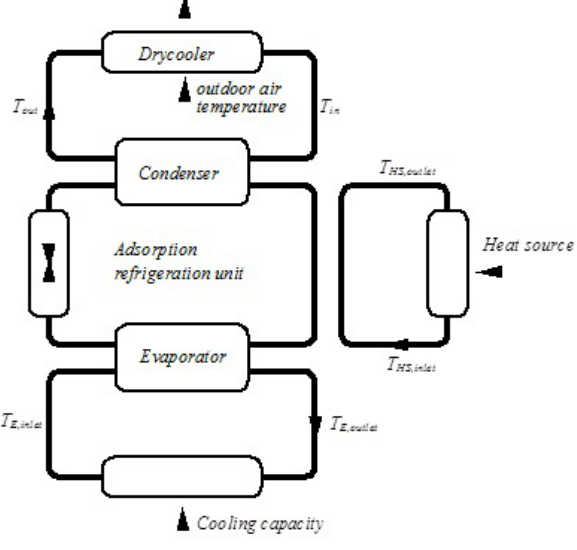
Figure 11: The adsorption refrigeration unit and cooperating